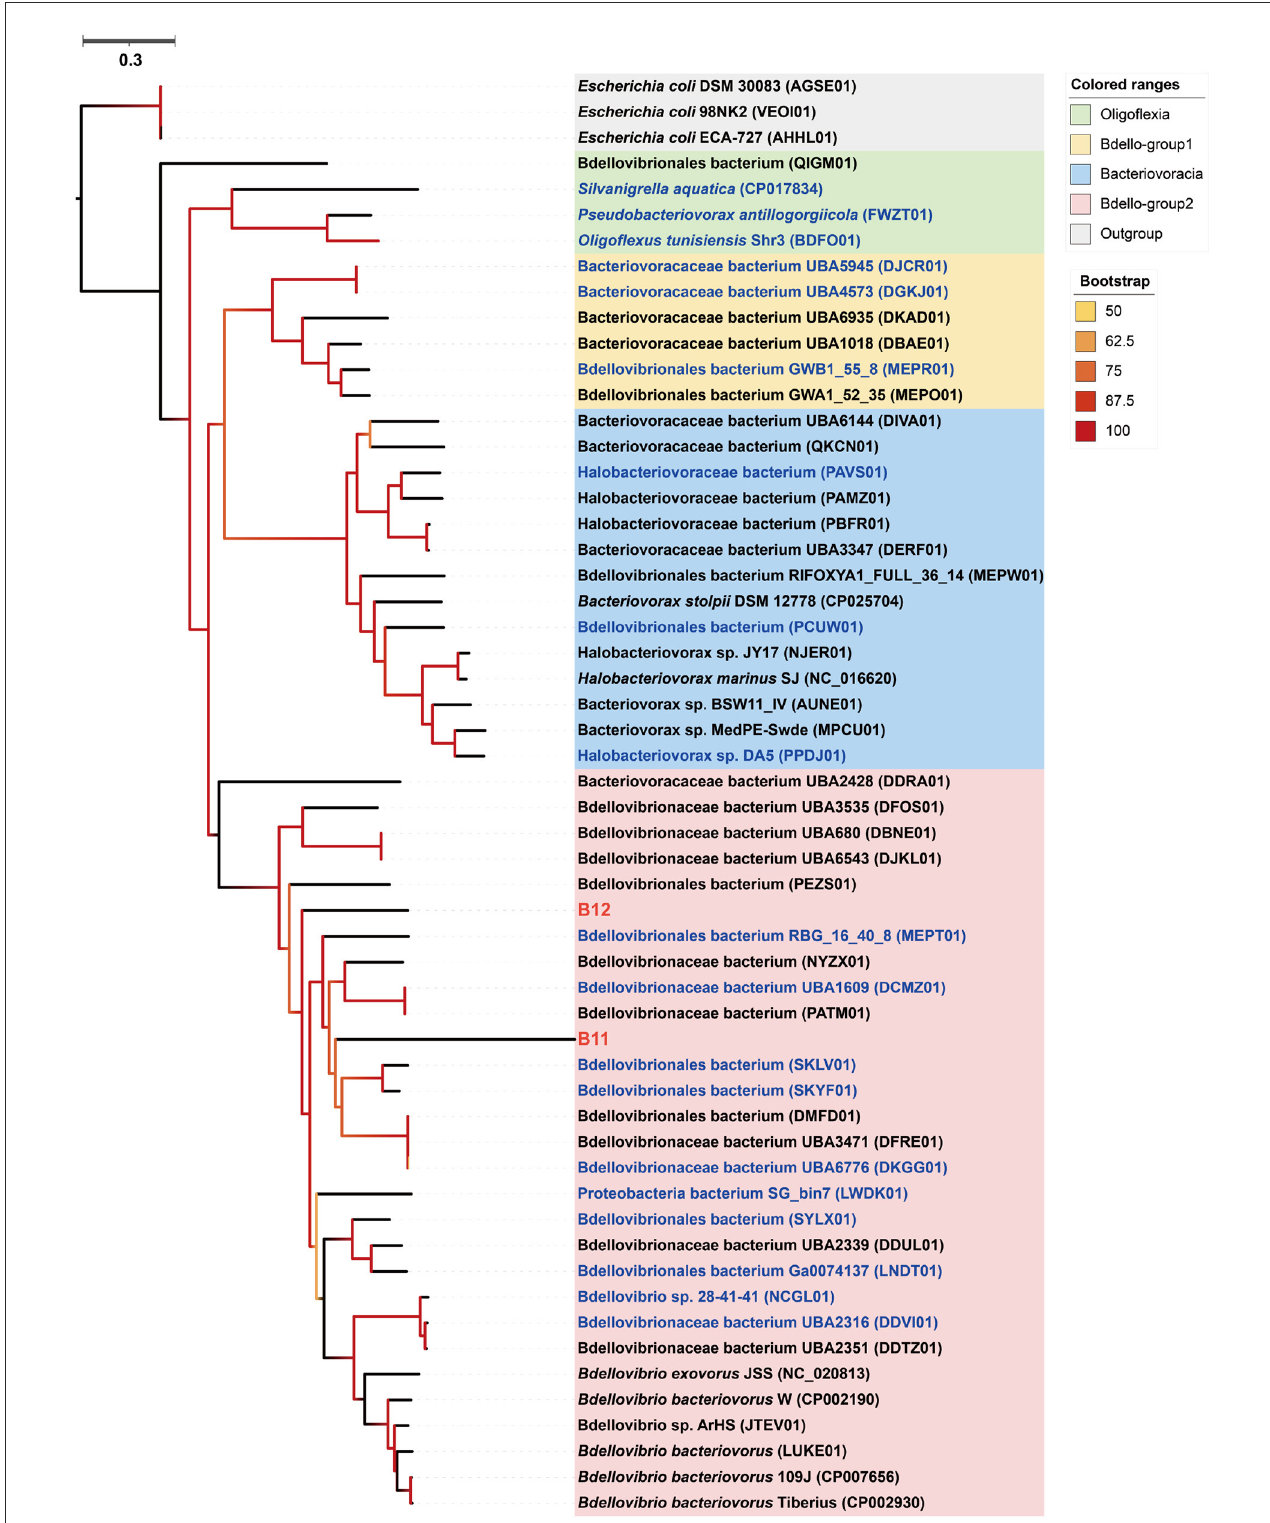
FIGURE5 Phylogenomic tree of the sponge-associated Bdellovibrionota MAGs. The maximum-likelihood tree was constructed using the “LG + F + R7” model. Escherichia coli DSM 30083, Escherichia coli 98NK2, and Escherichia coli ECA-727 were used as outgroups. Sponge-associated Bdellovibrionota MAGs B11 and B12 were colored in red. Free-living Bdellovibrionota MAGs with completeness > 90% were colored in blue.